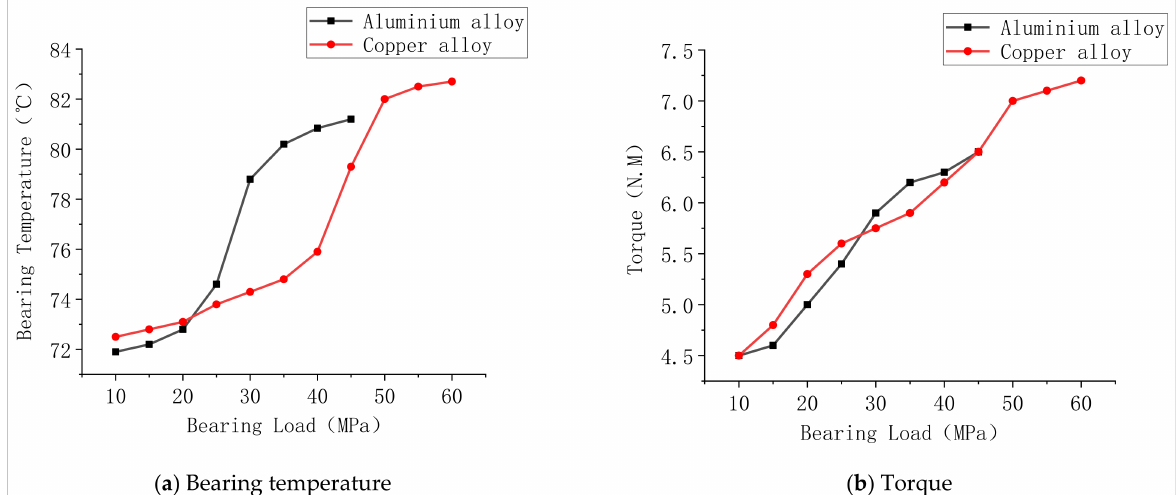
Figure 3. Comparison of bearing temperature and torque at different bearing loads.